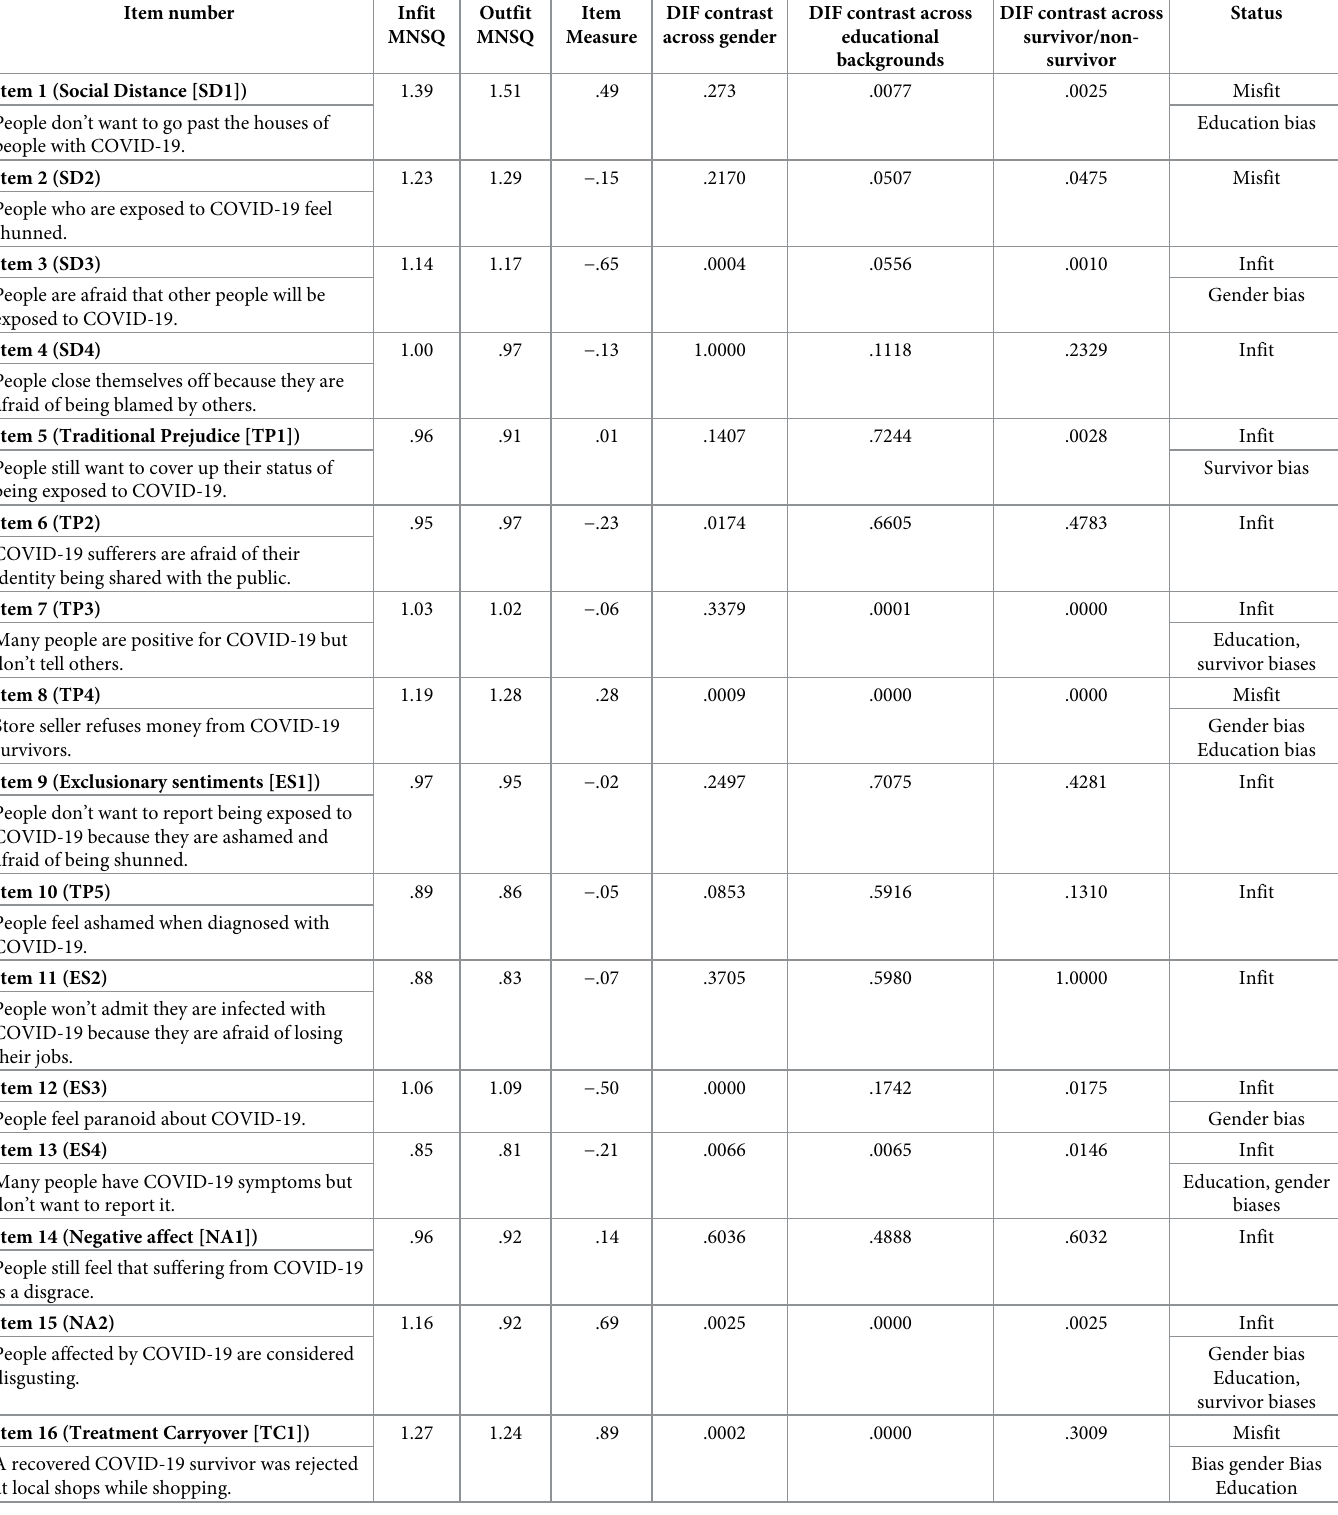
Table 2. Psychometric properties of the COVID-19 social stigma scale at the item level (N = 1,686). Item number